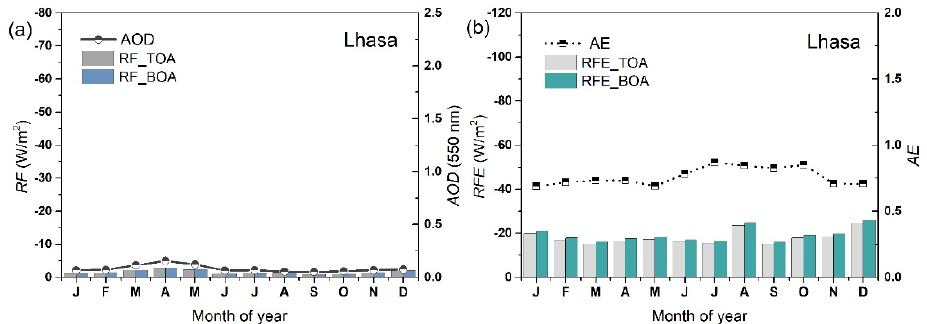
Figure 3. As Figure 2, but for the SONET continental background site. ( a ) RF at Lhasa; ( b ) RFE at